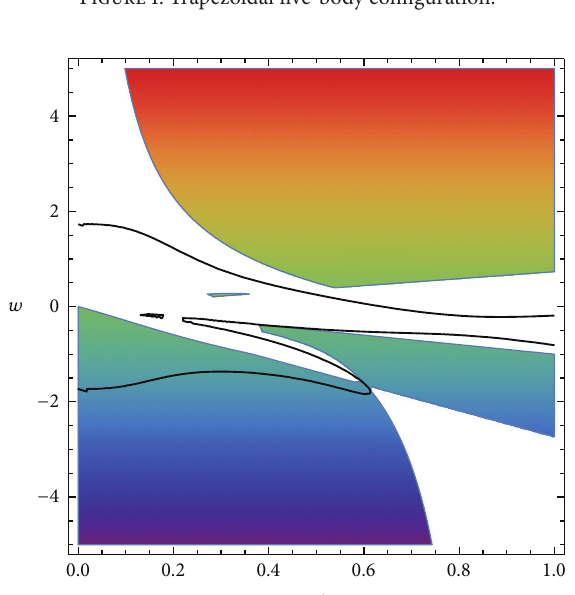
Figure 2: Central configuration region 𝑅 = 𝑅 𝜇 where both 𝜇 1 and 𝜇 2 are positive. The bold line corresponds to 𝐶(𝑡,𝑤) = 0 .